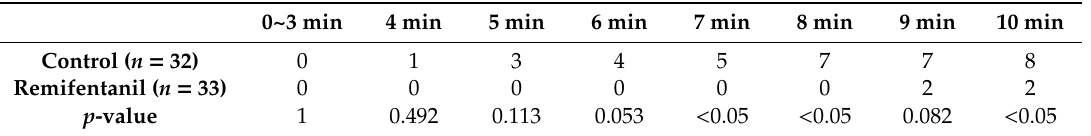
Table 2. Number of patients showing BSR ≥ 1% during 10 min of propofol-induced unconsciousness in the control and remifentanil groups.